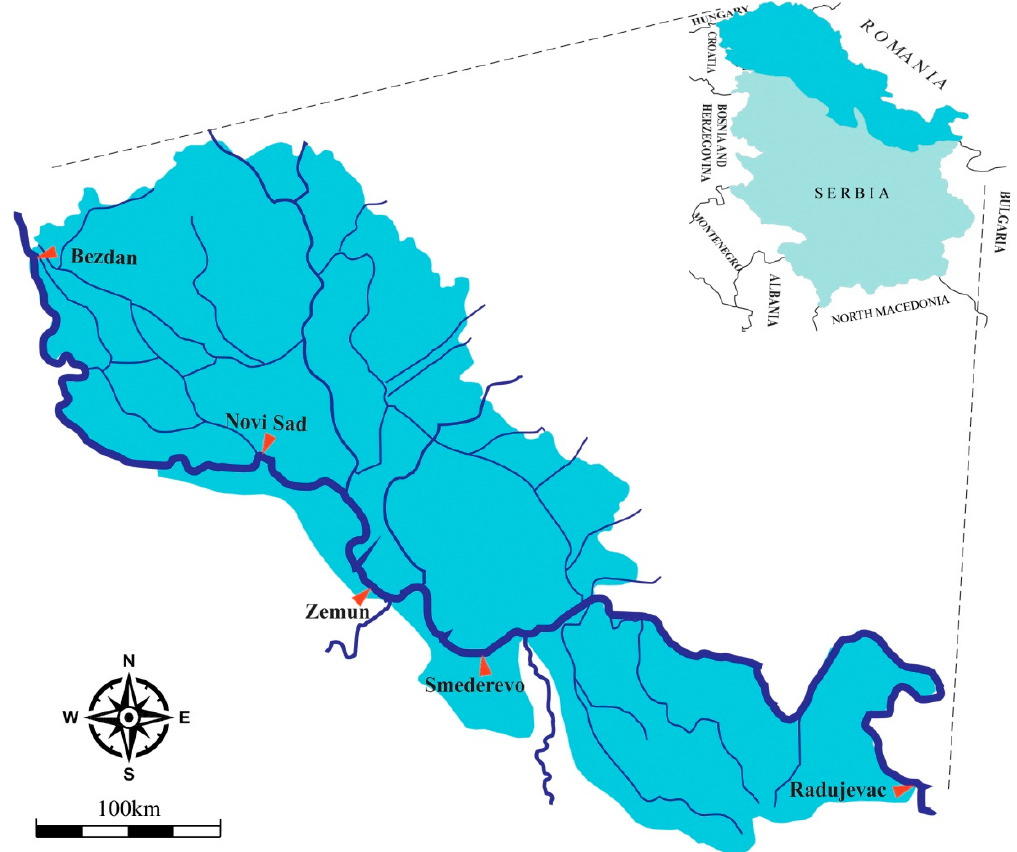
Figure 1. Observed sites of the Danube River flow in Serbia.